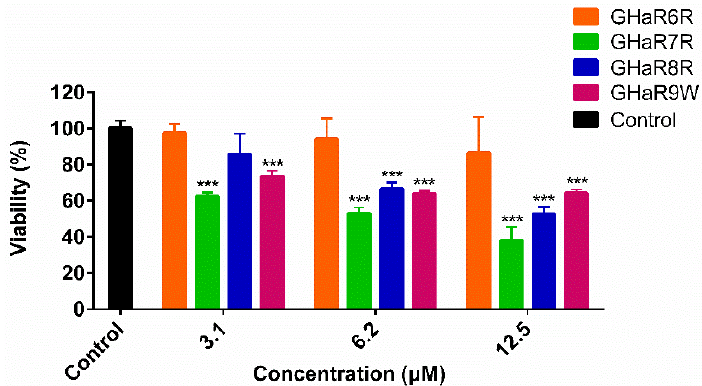
Figure 9. Cytotoxicity of GHaR6R, GHaR7R, GHaR8R, and GHaR9W. The viability of HOECs treated with the peptides at 3.1–12.5 μM was determined by using CCK-8. The negative control was treated with PBS only. (* p < 0.05, ** p < 0.01, *** p < 0.001).